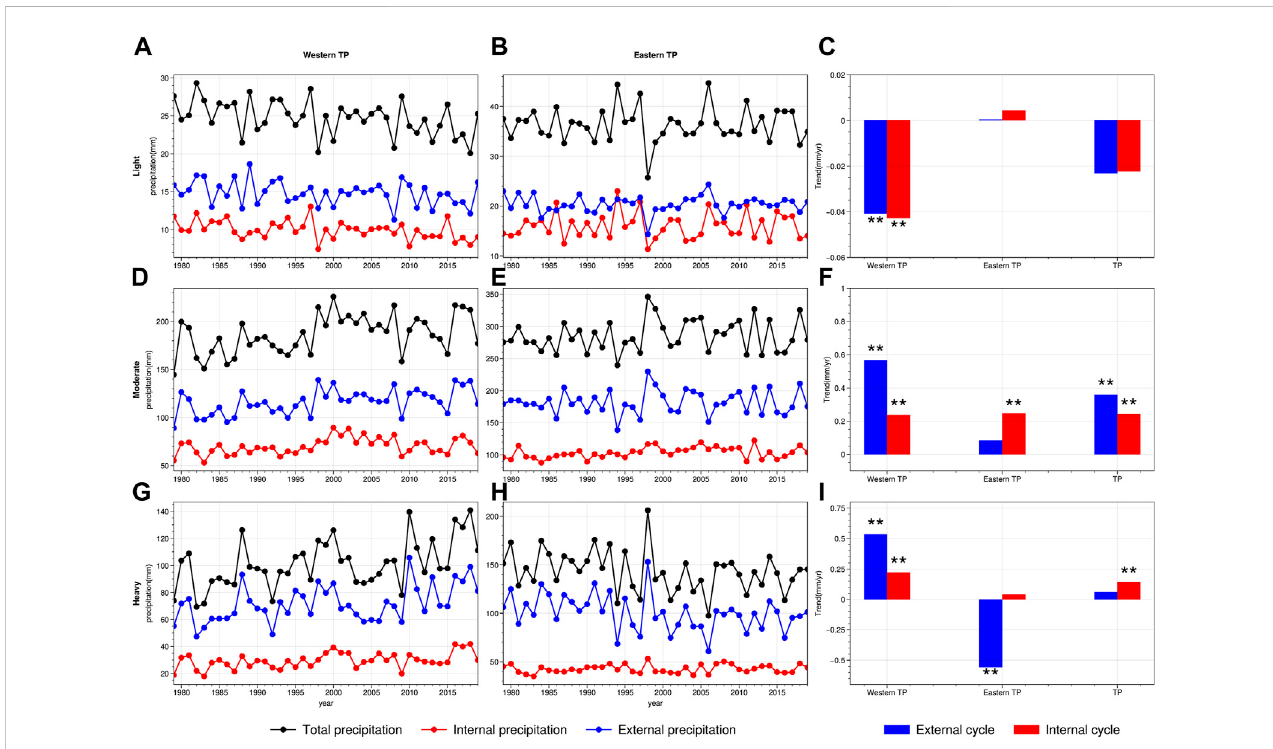
FIGURE 3 Time series of summer (June-August) total precipitation, external cycle precipitation and internal cycle precipitation and its corresponding trend. Black, red, and blue lines represent the total precipitation, internal cycle precipitation and external precipitation, respectively, for light (A,B) , moderate (D,E) and heavy (G,H) precipitation over the western (left column) and eastern (middle column) TP. Blue bars and red bars in (C,F,I) represent the trends of the precipitation amount associated with the external cycle and internal cycle over the western TP, eastern TP and TP, respectively. The stars indicate statistical signi fi cance exceeding